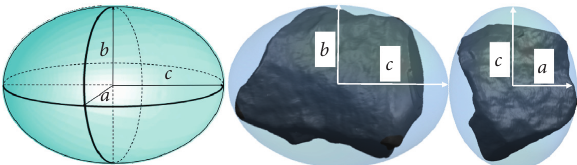
Figure 4: The circumscribed ellipsoid of the aggregate particles.